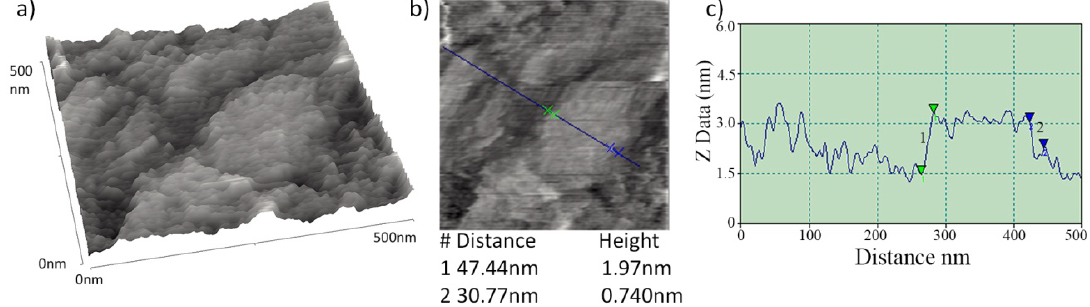
Figure 6. ( a ) Topographical contact mode AFM image of the graphene layer shown in Figure 3(e). ( b ) 2D, aerial view, of the same area. ( c ) Profile analysis of same, showing step heights of 1.97 and 0.74 nm, for arrow sets 1 and 2 respectively.